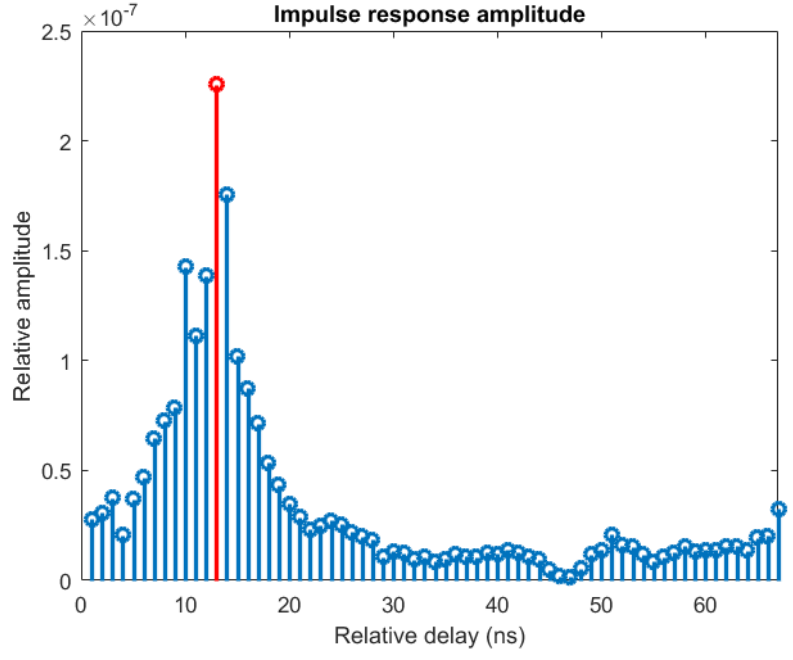
Figure 7. Identification of the different propagation contributions in the delay